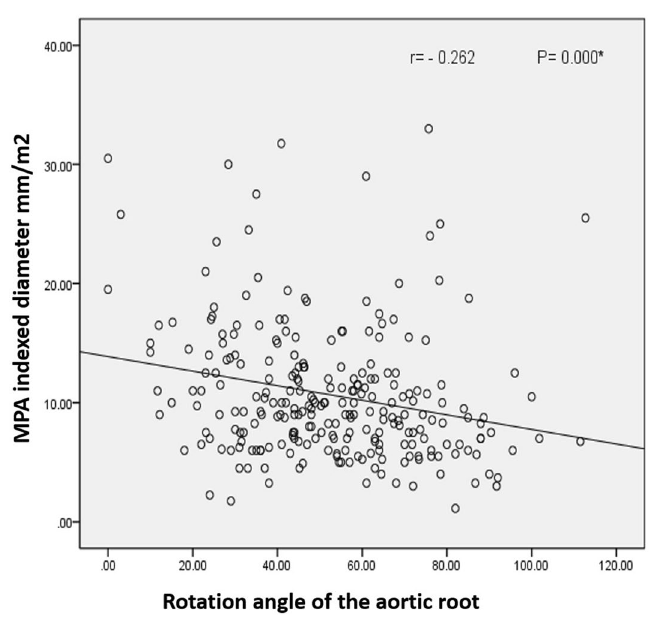
Figure 6. A negative correlation between the clockwise angle rotation of aortic root and MPA indexed